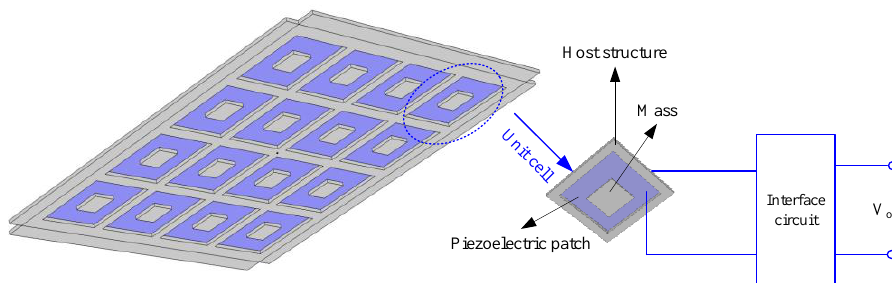
Figure 1. Schematic diagram of a PMPIC.